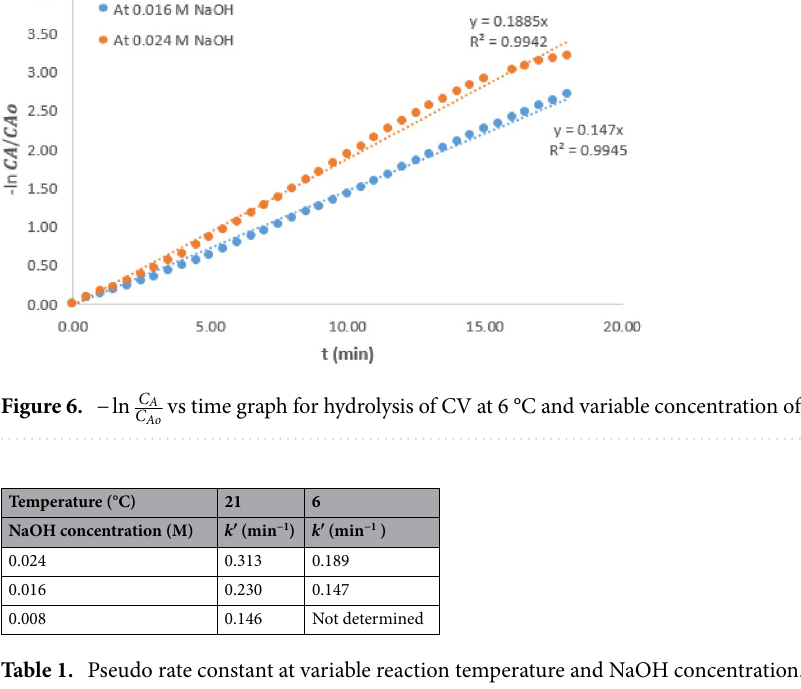
Table 1. Pseudo rate constant at variable reaction temperature and NaOH concentration.